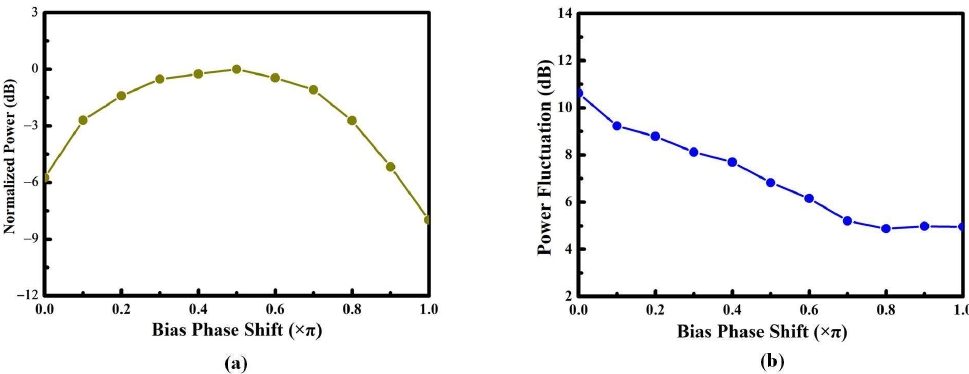
Figure 4. ( a ) Normalized power of the 5th-order multiplied-frequency component at 40 GHz, and ( b ) power fluctuation between the 1st-order multiplied-frequency component at 8 GHz and the 5th-order multiplied-frequency component at 40 GHz, under various bias phase shifts of the MZM.